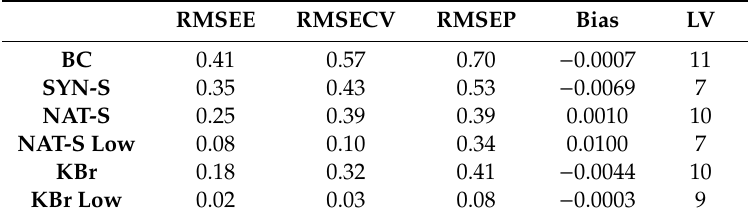
Table 1. Accuracy, bias, and the number of latent variables (LV) for the studied models and matrices. RMSEE